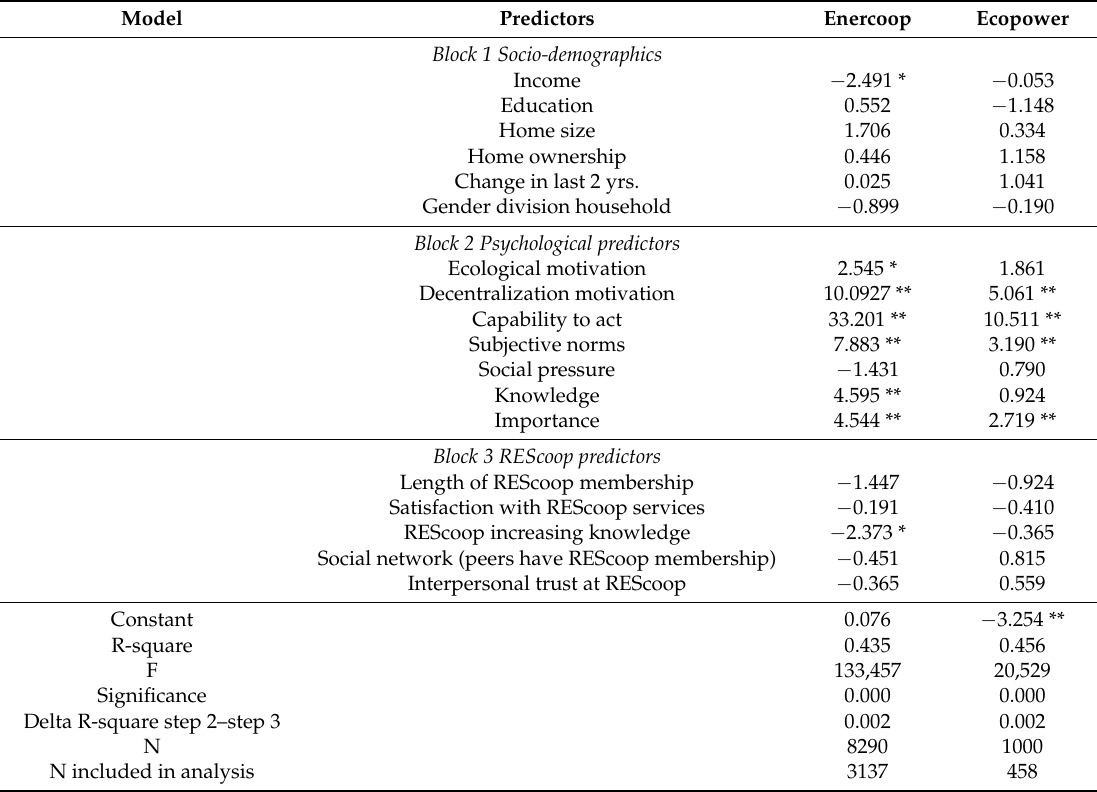
Table 8. Results of multivariate regression analyses on intention to save